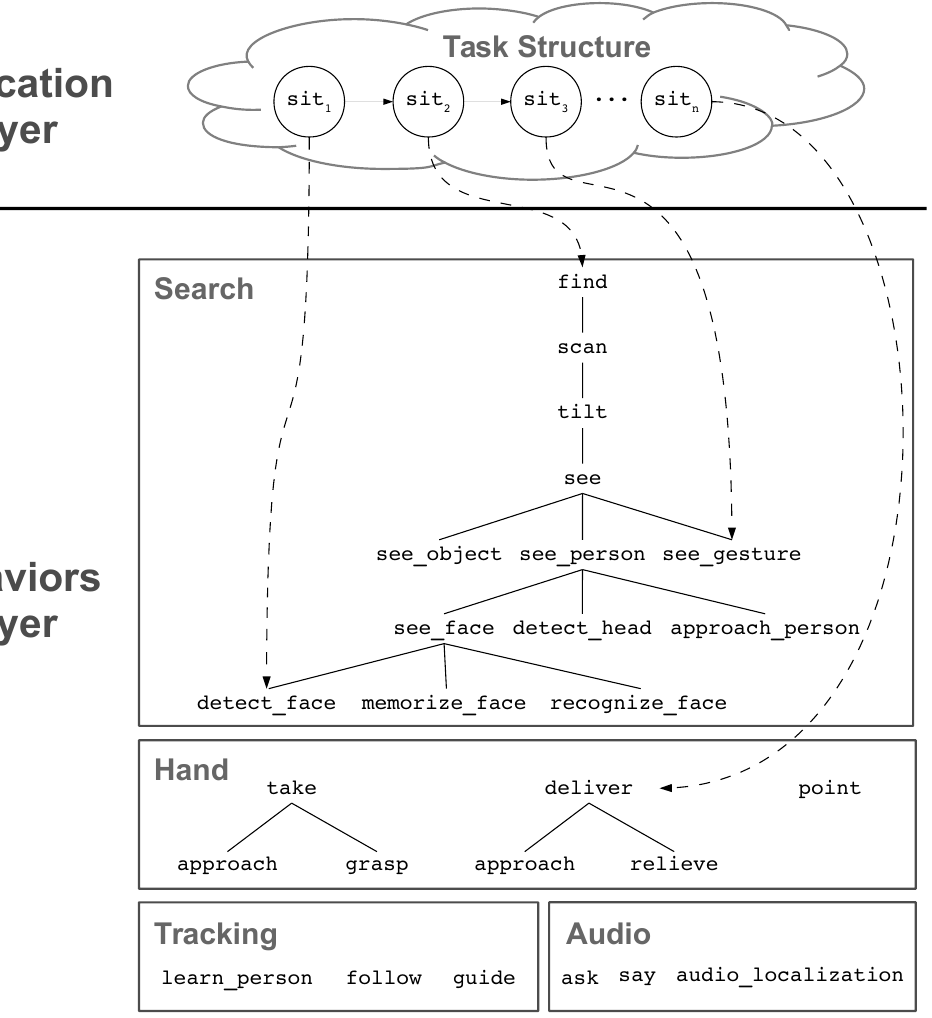
Figure 4. Tasks and